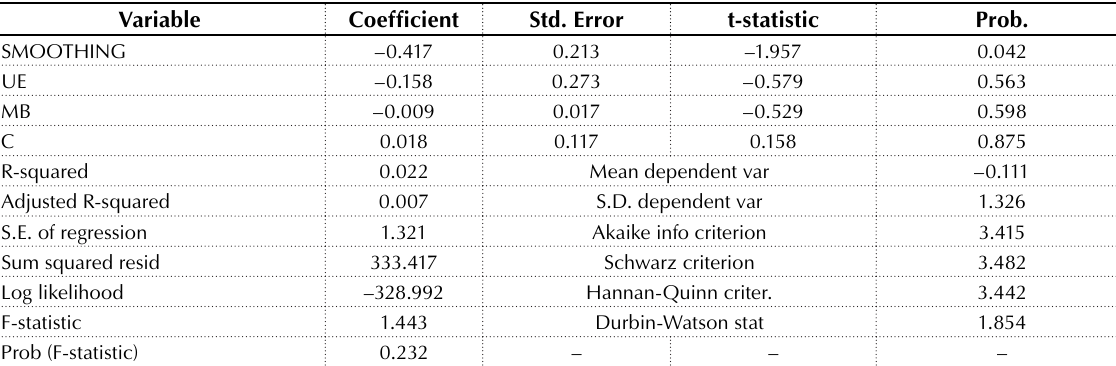
Table 1. Regression analysis for research model